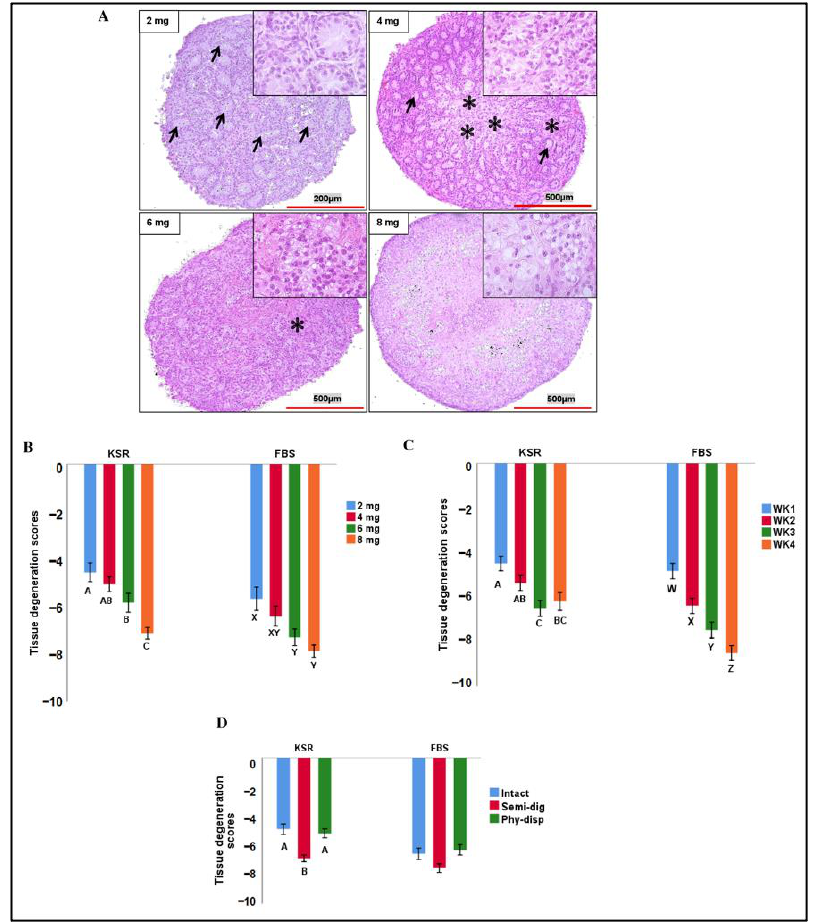
Figure 2. The effects of fragment size, tissue preparation method, and week of culture on tissue degeneration scores. ( A ) Representative photomicrographs of tissue fragments of different sizes retrieved at week 4 of the culture. Smallest size fragments (2 mg) better maintained their tissue integrity where seminiferous cords (arrows) were discernible throughout the tissue. Conversely, the increase in tissue fragment size that coincided with an increased loss of discernible seminiferous cords and presence of degenerated and disorganized features of spermatogenic epithelium and reduced spermatogenic cell numbers, especially in central areas, can be seen (asterisks). ( B – D ) A semi-quantitative histopathological assessment was conducted to compare morphological damages observed in the cultured testicular tissue fragments over time. This tissue degeneration score ranged from 0 to − 10, where 0 represented no tissue damage and − 10 represented most damage. ( B ) Overall, in both FBS- and KSR-supplemented media, smaller fragments had less degeneration scores than larger fragments. ( C ) In general, tissue degeneration continued over the course of culture. ( D ) In KSR- supplemented media, intact and physically dispersed (Phy-disp) fragments had less degeneration than semi-digested fragments (semi-dig); however, those in FBS-supplemented media did not differ. Data with different letters within each media supplement differ significantly ( p <